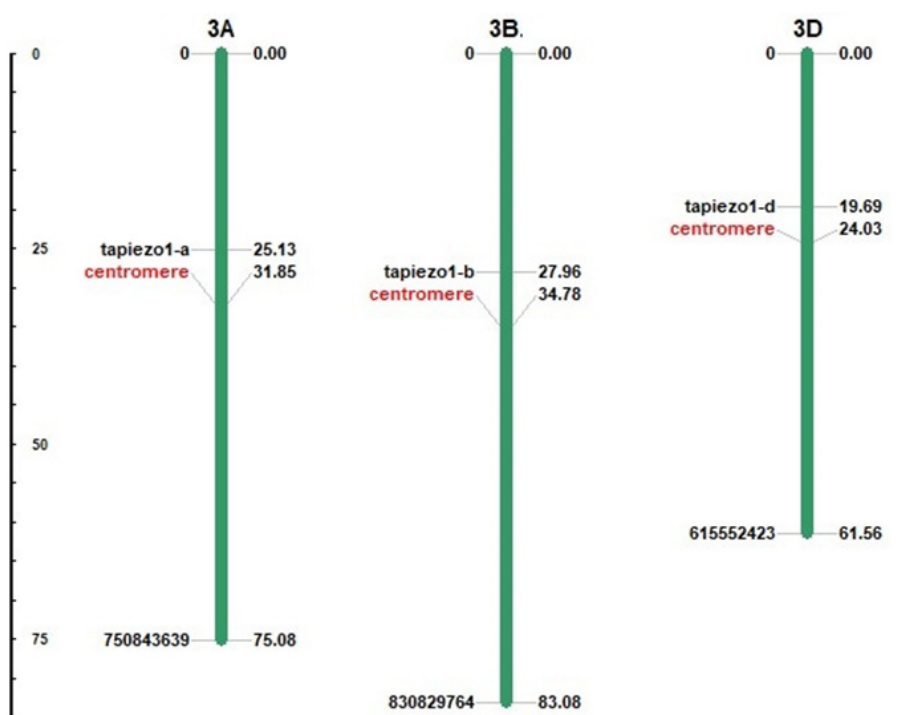
Figure 1. The chromosomal position of TaPiezo genes. TaPiezo genes are found on chromosomes 3A, 3B and 3D of T. aestivum